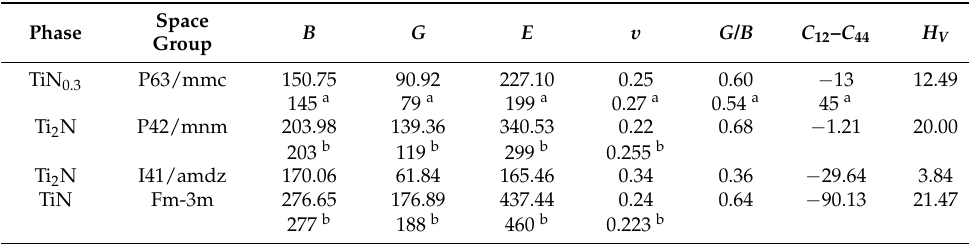
Table 8. The calculated bulk modulus B (GPa), shear modulus G (GPa), Young’s modulus E (GPa), Poisson’s ratio υ , Pugh’s ratio G/B , Cauchy pressure C 12 – C 44 , and Vickers hardness H V for Ti-N compounds. Space B G E υ Phase Group TiN 0.3